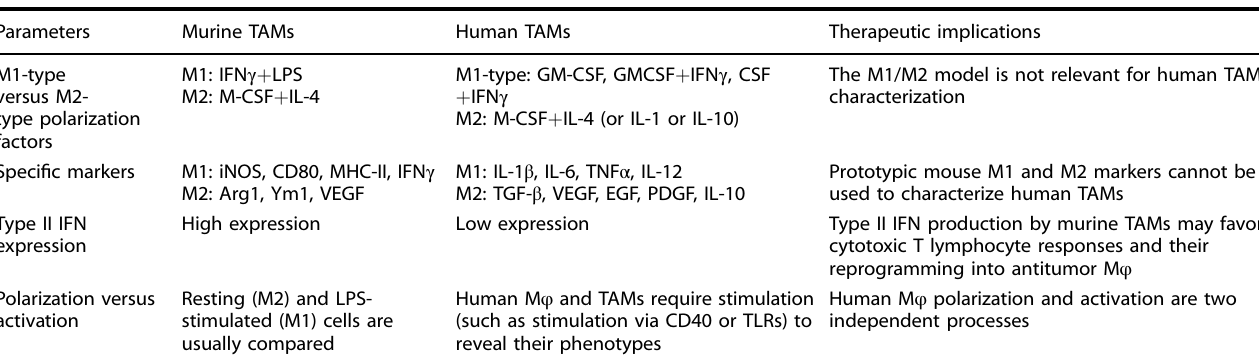
Table 2. Differences between mouse and human